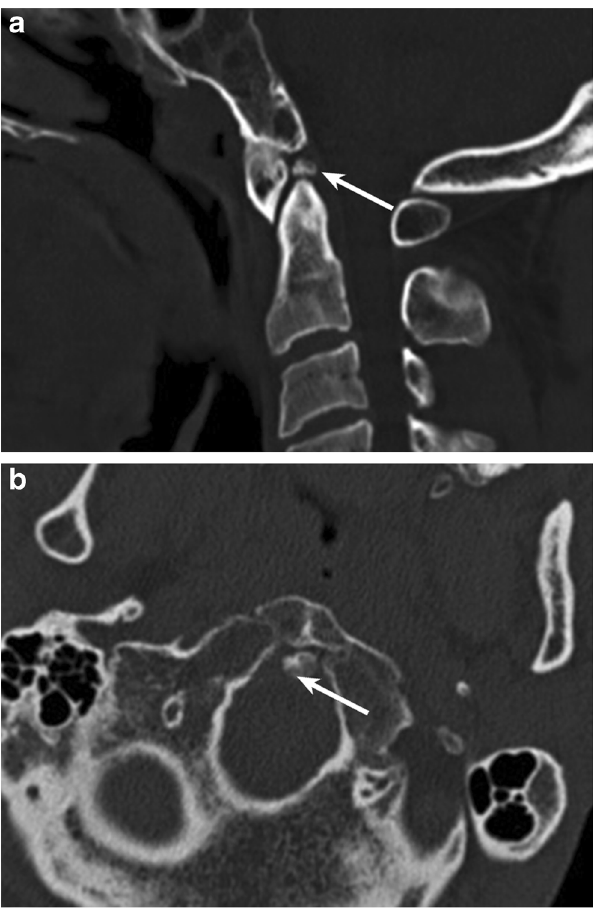
Fig. 16 Hypoplasia/aplasia of the posterior arch of C1. Axial CT images at the level of the atlas on two patients reveal cervical vertebral cleft (posterior rachischisis) in a and absent posterior arches in b . Also note anterior vertebral body clefts on both